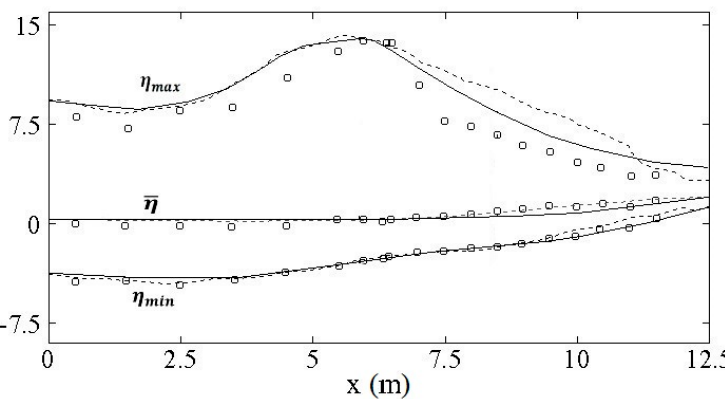
Figure 7. Ting and Kirby [21] spilling breaking wave test case. Mean water level and distribution of phase-averaged crest and trough elevations along the cross-shore direction. Comparison between experimental data (empty circles) and numerical results obtained by the Gallerano et al. [14] numerical model with (solid line) and without (dashed line) the modified 𝑘 − 𝜀 turbulence model.